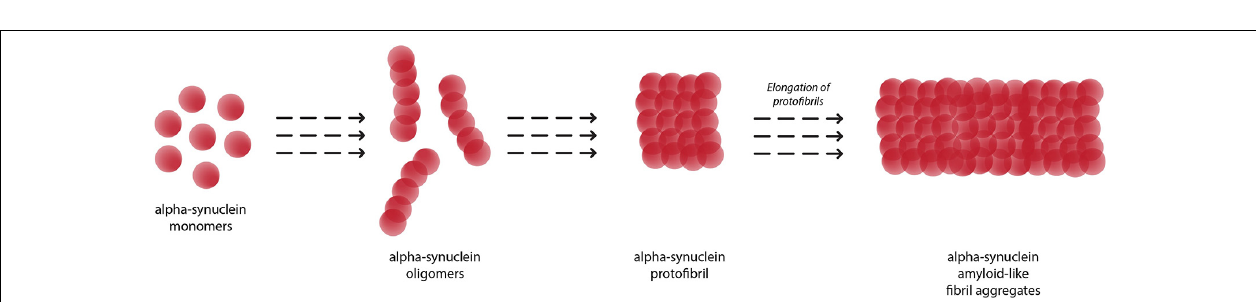
FIGURE 1 | Schematic structure of α -synuclein. Reprinted from Stefanis (2012), with permission from Cold Spring Harbor Laboratory Press.